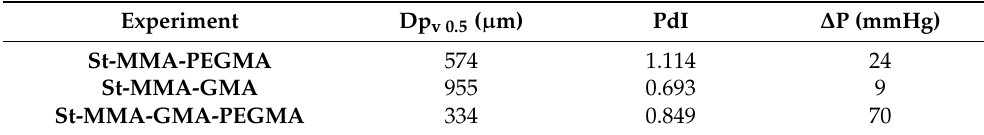
Table 4. Median diameters in volume and PdIs of St-MMA functionalized particles, and estimated pressure